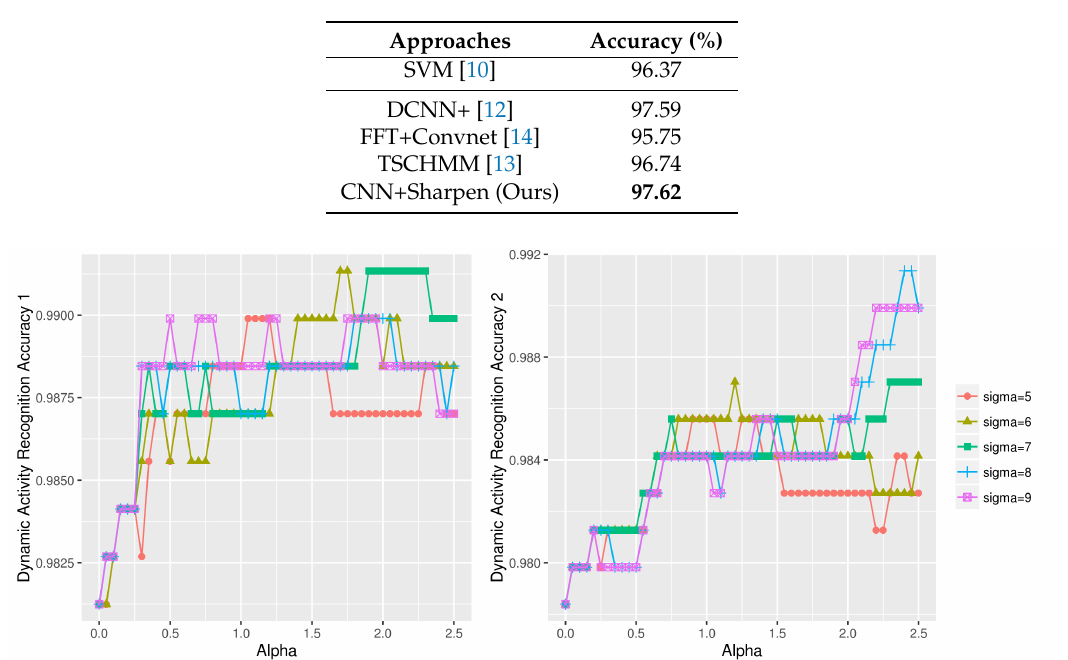
Figure 17. Dynamic activity recognition accuracy using various ( σ , α ) combinations on UCI HAR dataset (left: dynamic test data1, right: dynamic test data2).